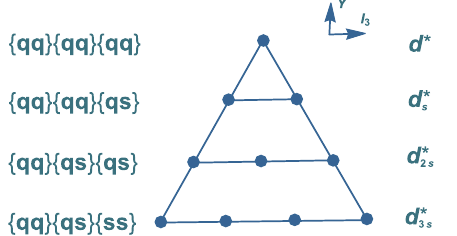
Fig. 1 Weight diagram of ¯ 10 f of the flavor SU(3) group. The com- ponential diquarks of each isospin multiplets are labeled at the left- hand side. The symbols d ∗ s , d ∗ and d ∗ are introduced as the names of 2 s 3 s d ∗ ( 2380 ) ’s partners with 1, 2, and 3 strange quarks, respectively, which have been marked at the right-hand